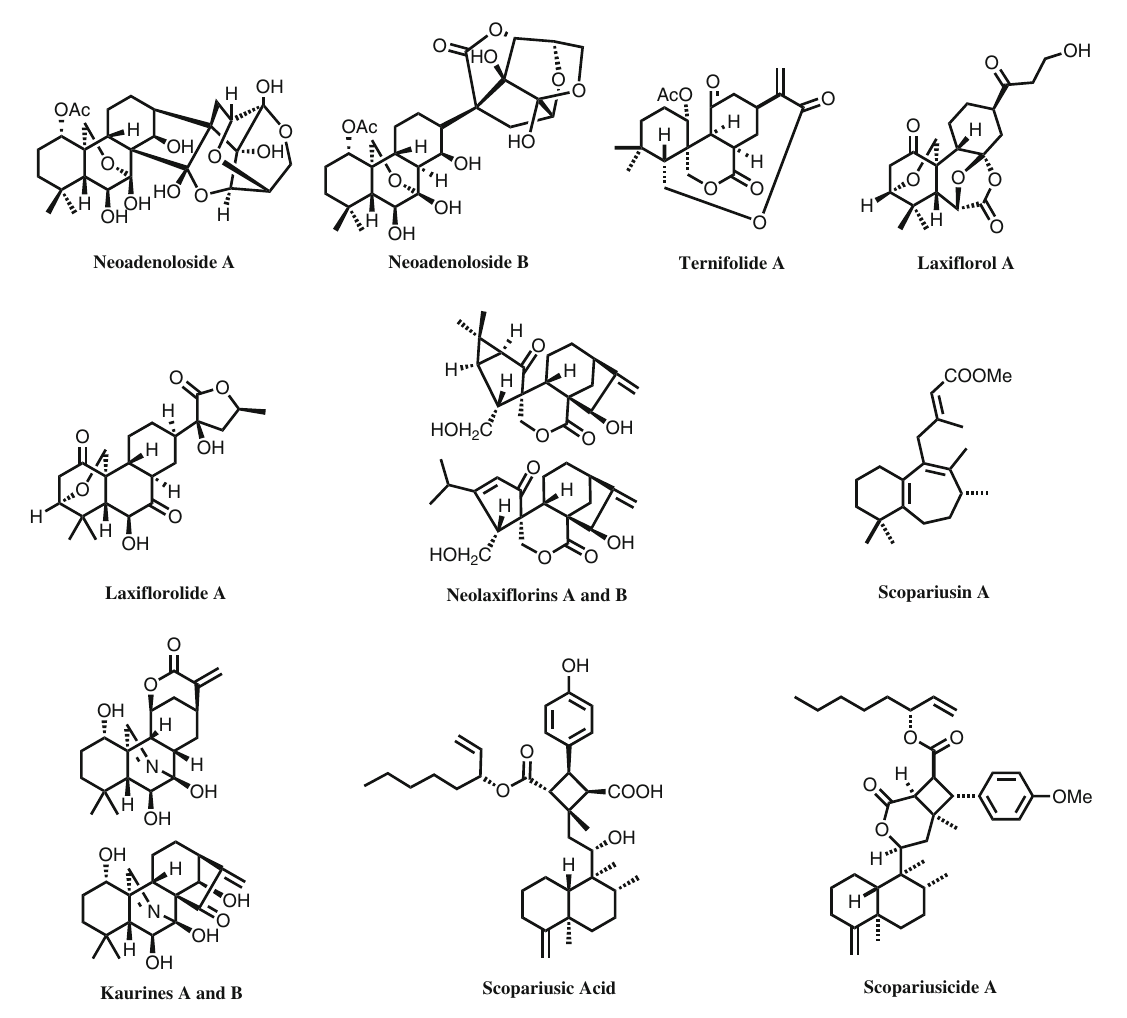
Fig. 5 Representative novel diterpenoids from Isodon